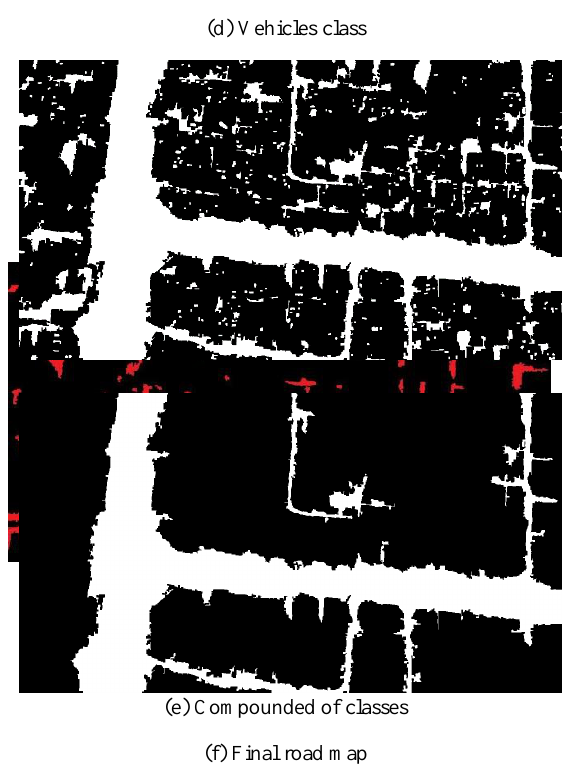
Figure 3. (Test Image I): 3(a) Road class; 3(b) Tree class;